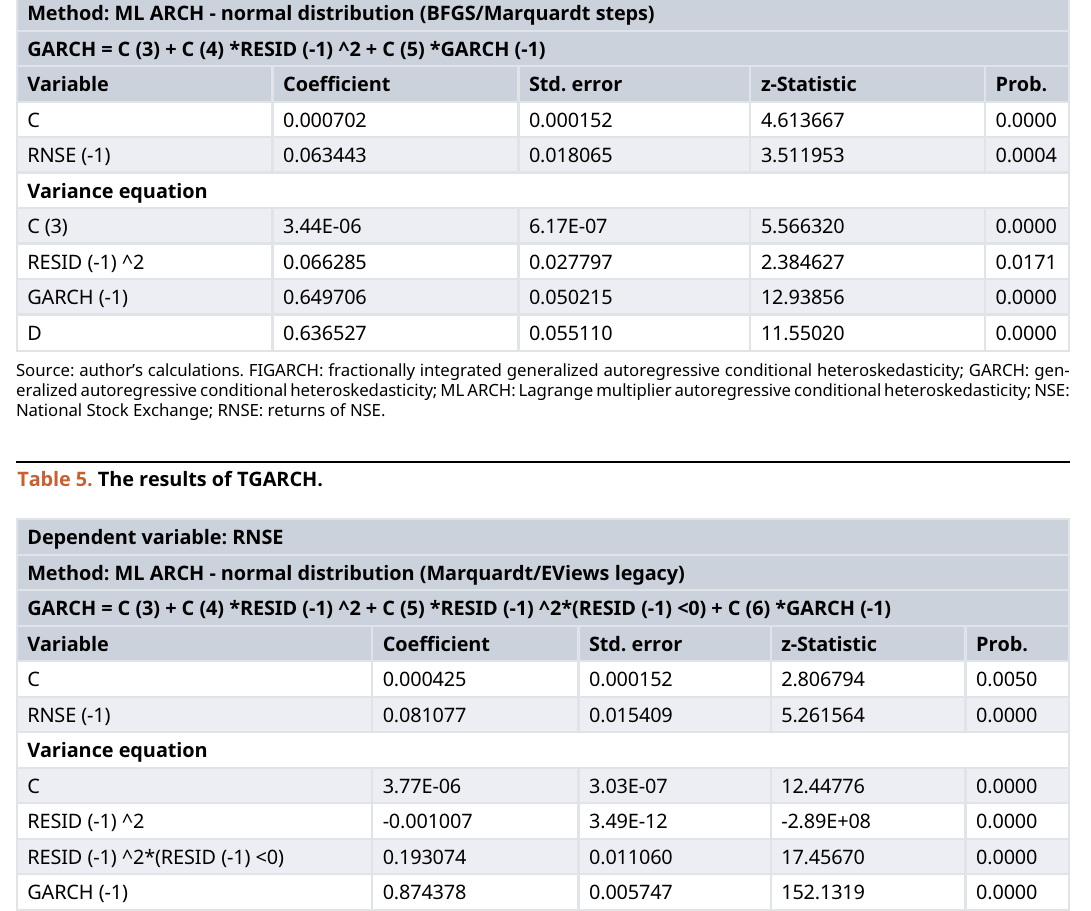
Table 4. The outcome of FIGARCH for the daily returns of NSE. Dependent variable: